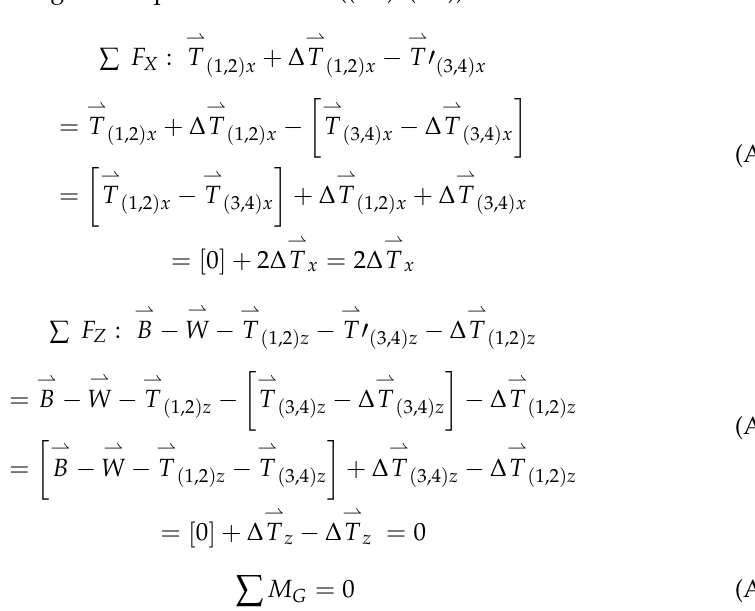
Figure A3. Case 3: Co-located C and G (with balanced thrust increase). The corresponding static equations become ((A7)–(A9)):